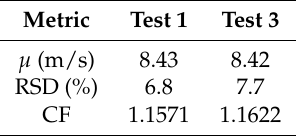
Table 1. Mean, RSD and CF of the wind time series: test 1 and test 3.